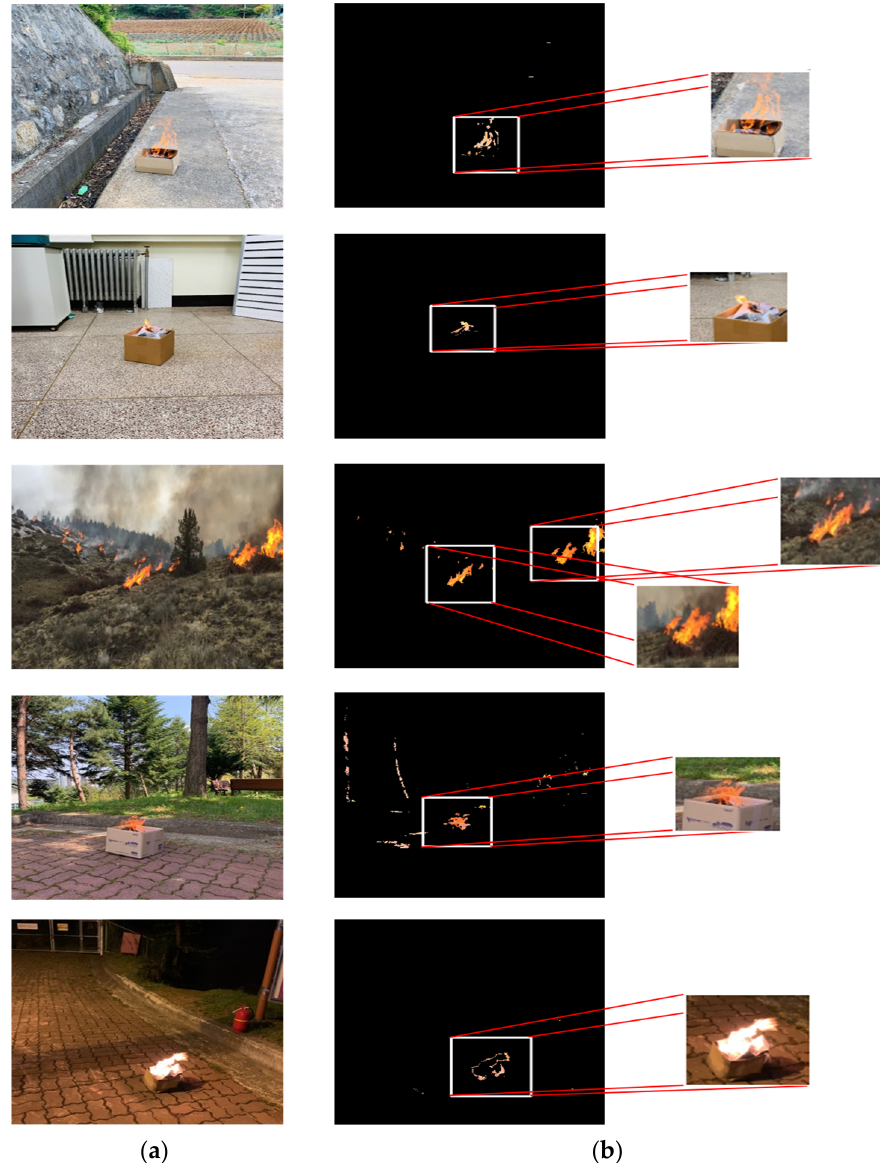
Figure 5. Extraction of final flame candidate regions. ( a ) Original images; ( b ) Detection of candidate regions using the proposed method.